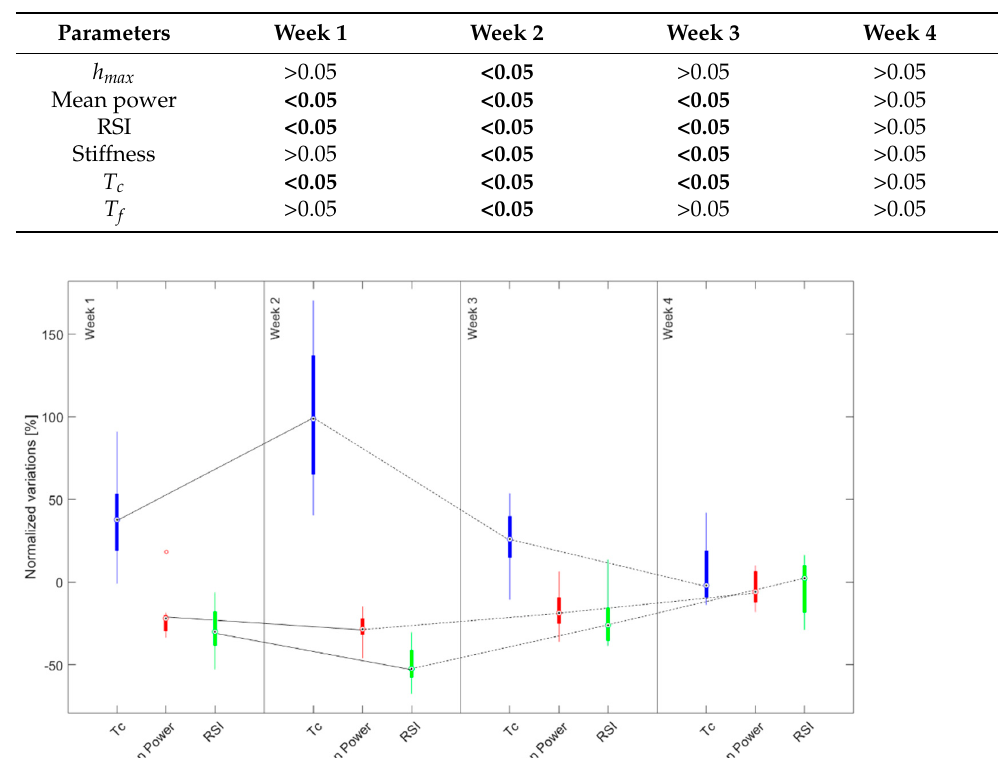
Table 4. Wilcoxon test p -value (Cliff’s delta) shadowed cells indicates a significant effect of the fatiguing protocol on Bosco test parameters.